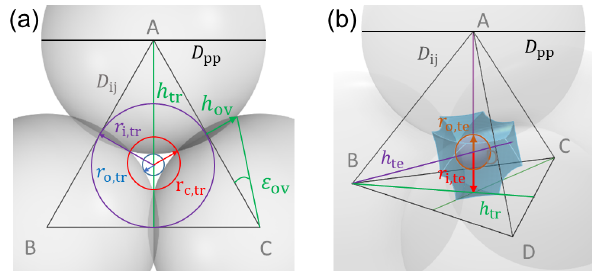
Figure A1. Dimensions of the different pore types formed in the case of a tetrahedral packing arrangement, where four overlapping spheres of diameter D pp are arranged on the corners of a regular tetrahedron, indicated by A, B, C, and D. (a) Top view of the three- membered ring pore that forms between the three spheres with cen- tres at the corners of the triangle ABC. (b) The inner cavity formed within the tetrahedral cell with apices at the centres of the spheres A, B, C, and D has the form of a concave